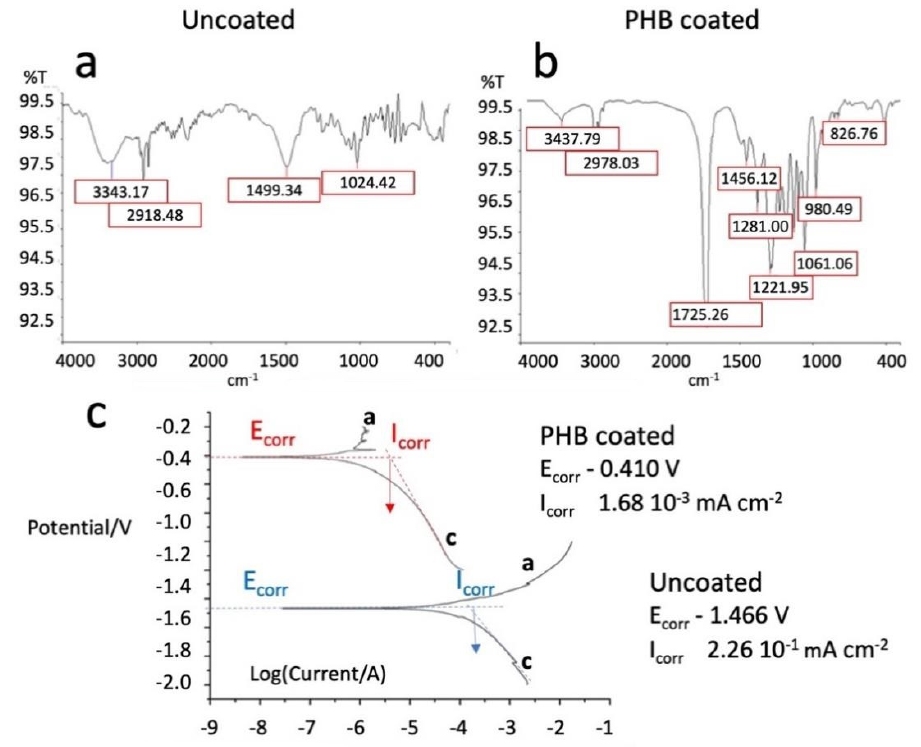
Figure 2. ( a ) FTIR spectra results of AZ31 and ( b ) AZ31 with PHB coating; ( c ) comparison of polarization curves and natural corrosion potential (E corr ) and current (I corr ) for PHB-coated and uncoated AZ31 Mg alloy.